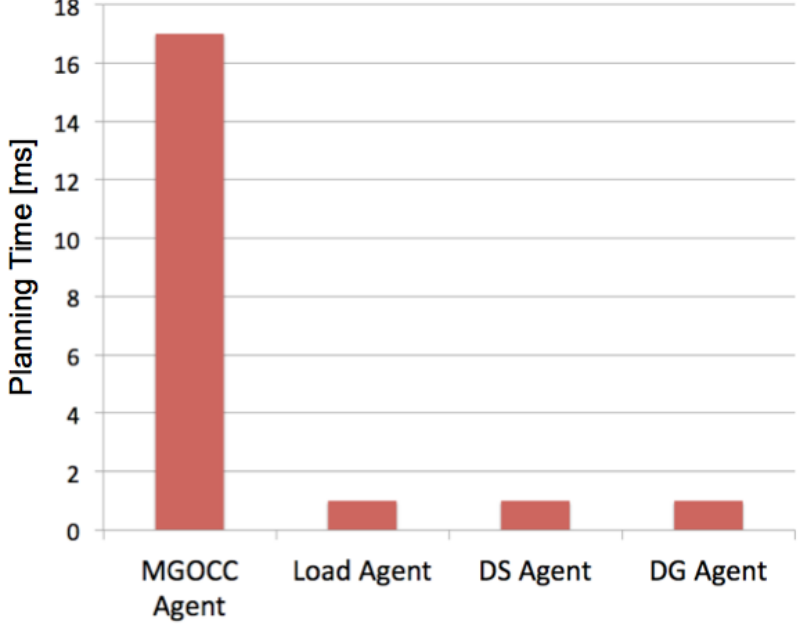
Figure 24. The calculation time of the proposed multiagent